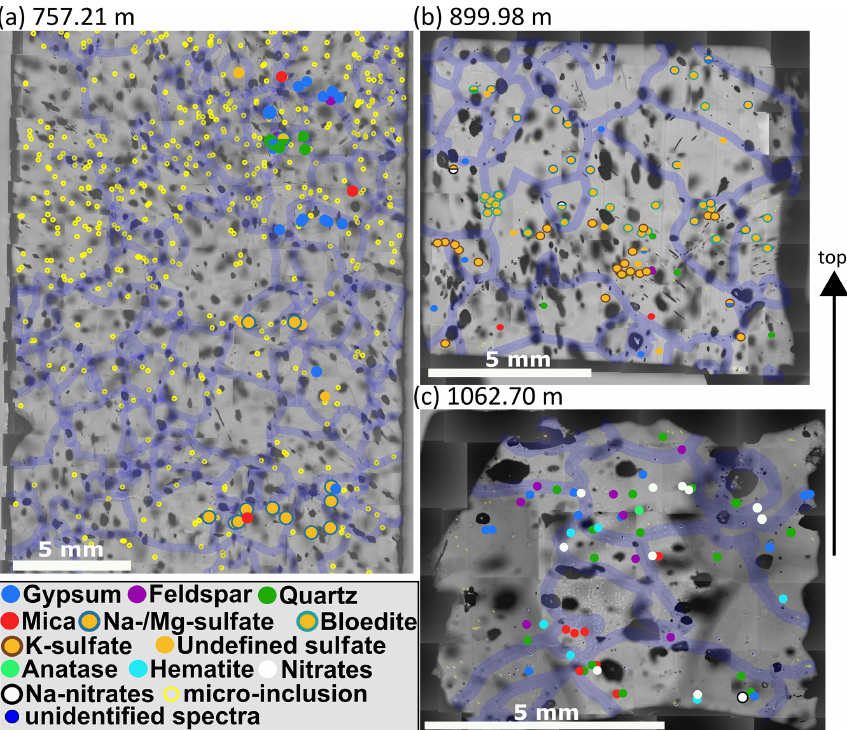
Figure 8. Impurity maps from depths of 757.21 (S6), 899.98 (S7), and 1062.7m (S8). Same annotations as in Fig. 7. (a) Mineralogy changes within centimetres along the vertical axis. The shallower part is dominated by gypsum and terrestrial dust, while the deeper part is dominated by Na and/or Mg sulfates. (b) A strong sulfate layer is found in the middle of the sample, and terrestrial dust is mainly found below. (c) Mineralogy differs strongly from the shallower samples: sulfates are less diverse, mineral dust and nitrates dominate, and clusters are less